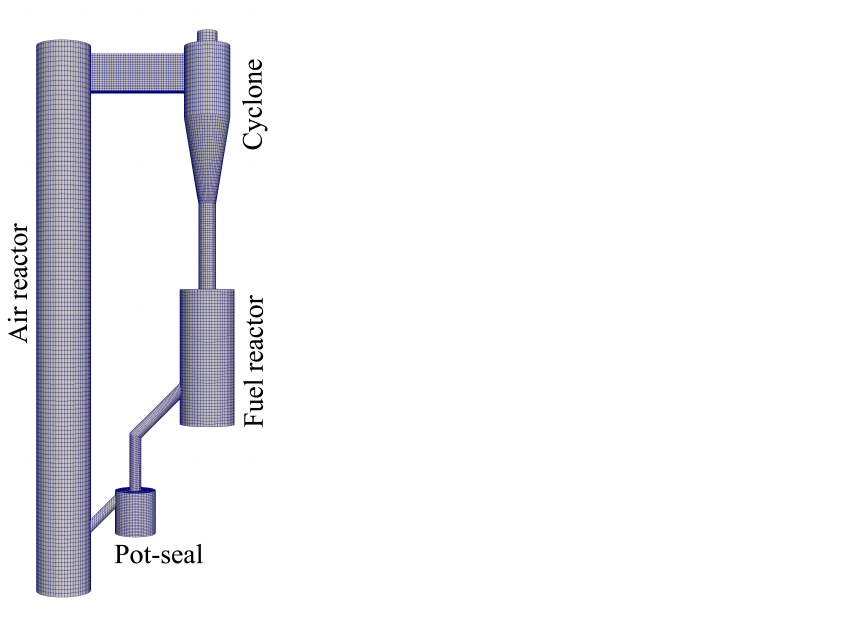
Figure 2. Geometry of CLC system. The amount of cell is 0.33